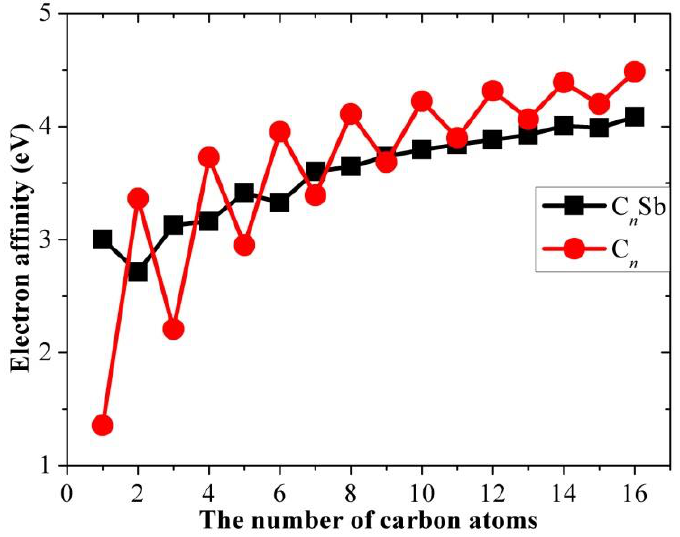
Figure 9. Adiabatic electron affinities of neutral C n Sb and pure carbon clusters C n as a function of the number of carbons.